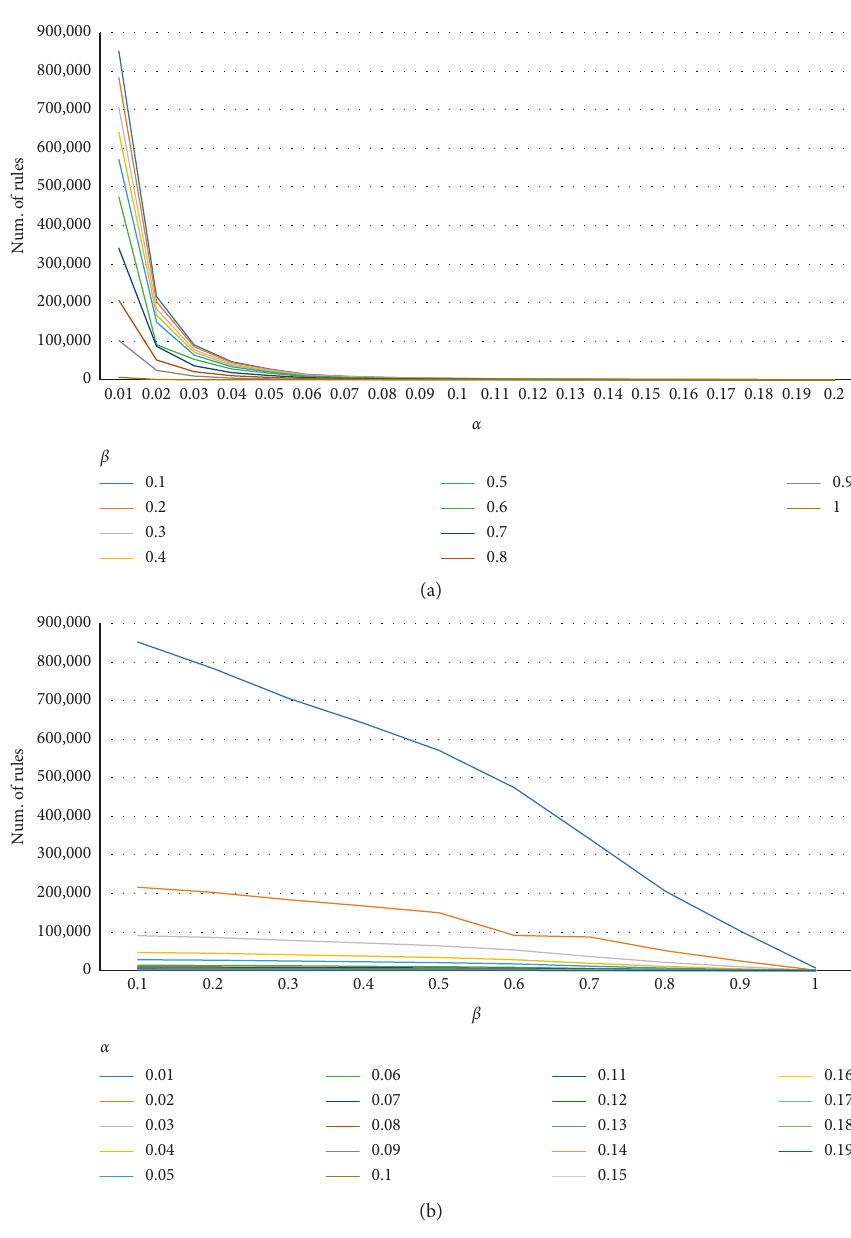
Figure 2: Distribution of association rules based on (a) minimum support ( α ) and (b) confidence ( β )